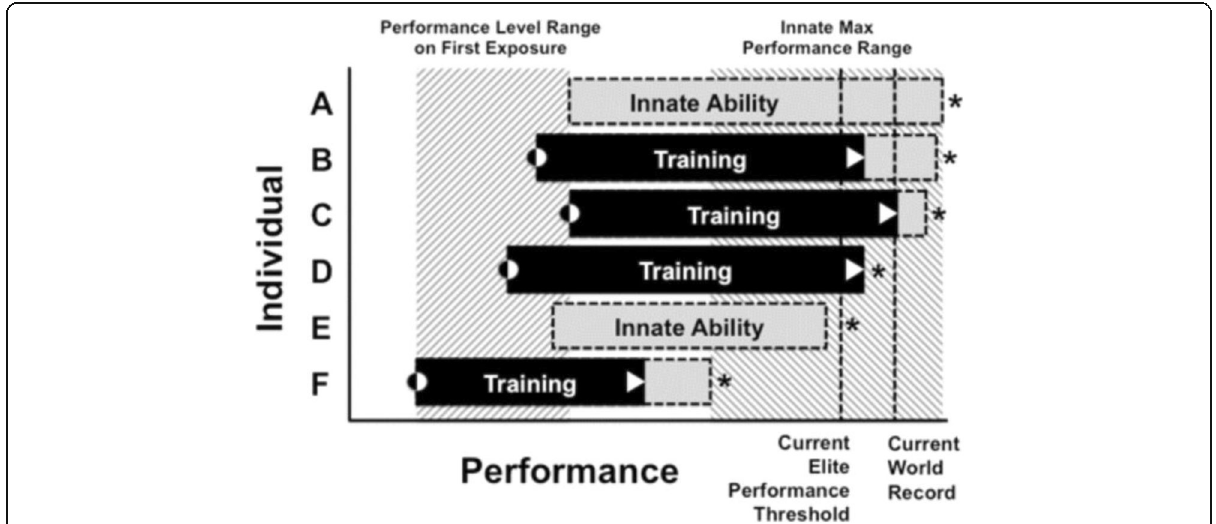
Fig. 1 A theoretical model illustrating inter-individual variation in performance and potential (reproduced from [8]). Here, six individuals (A – F) have differing initial performance levels (performance level range on first exposure); F has the lowest, and C has the highest. The individuals also have different ceilings to his/her performance (innate max performance range), with A having the highest potential. However, training represents the journey from baseline potential to final potential; A and E do not train, and so will never reach their ceiling. Whilst C is the current world record holder, B has the potential to outperform them — but only if B can maximize their training to drive the required response. Legend: Max = maximum; asterisk = maximum performance threshold for each individual; triangle = current performance level; black-white circle = initial performance level. Reproduced from [8]. Permission has been granted for